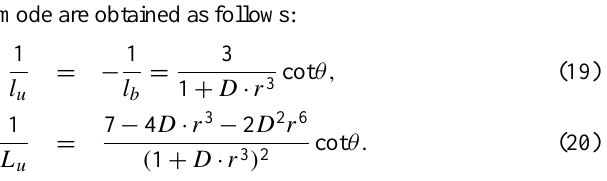
corresponding parameters of the eigenfrequency ω 0 , the pe- riod T 0 , the colatitude θ 0 and the radial distance r 0 where ω c = ω 0 are given in Tables 2 and 3 for the noon and mid- night side, respectively. The profiles of ω c and f show signif- icant differences among the cases of noon, midnight merid- ional plane of the compressed dipole, and that of a standard dipole, especially for greater L values. For example, for